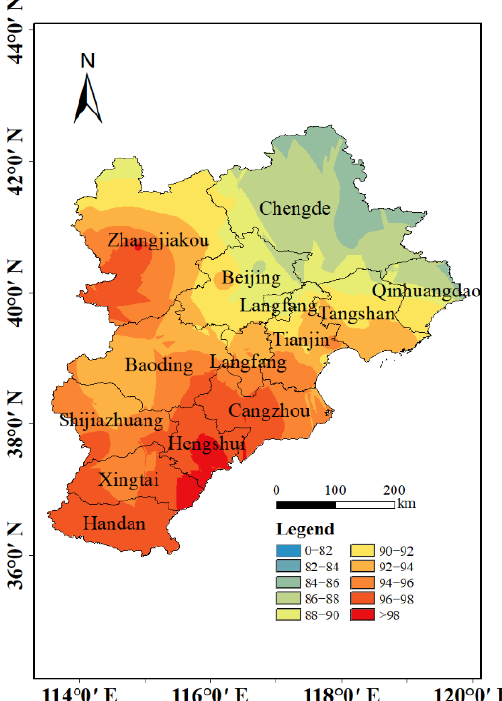
Figure 7. Estimation of 4-year average O 3 exposure level.